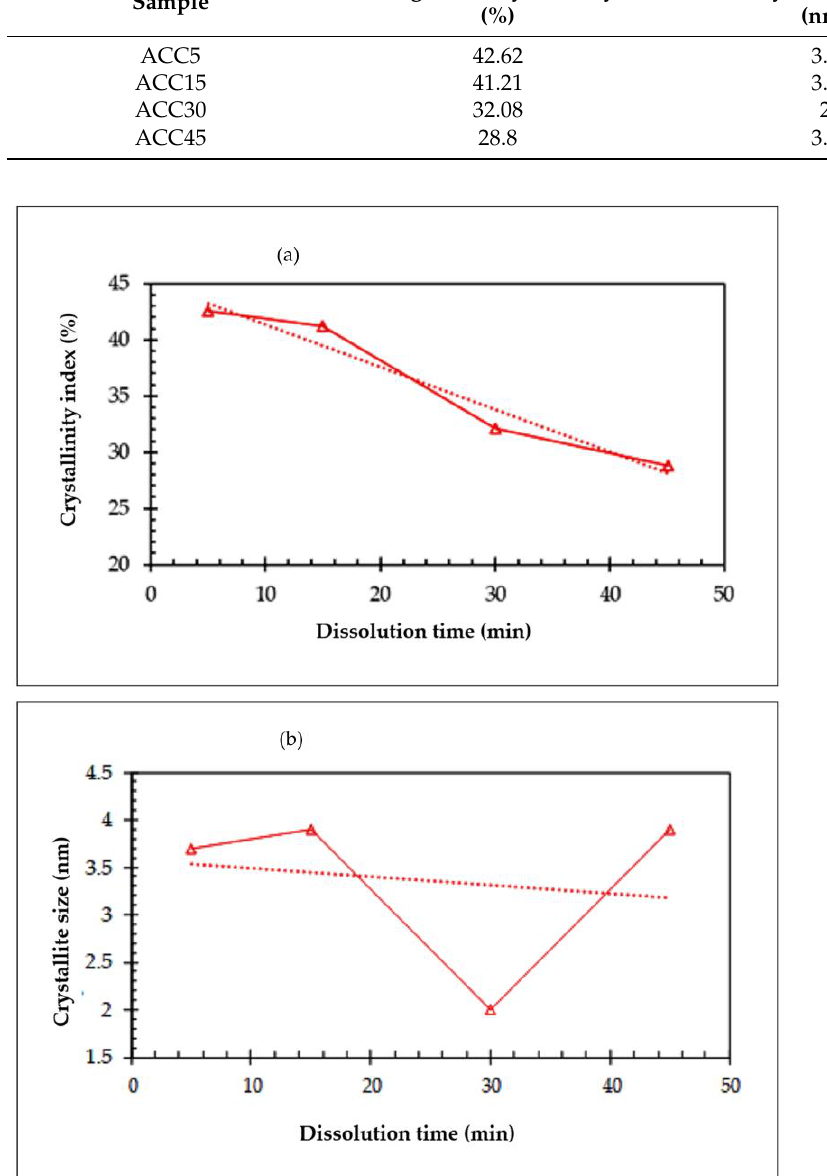
Figure 6. The variations in crystallinity index and crystallite size. ( a ) Crystallinity index; ( b ) Crys- tallite size Table 4. Degree of crystallinity and crystallite size of the ACCs of the ACC